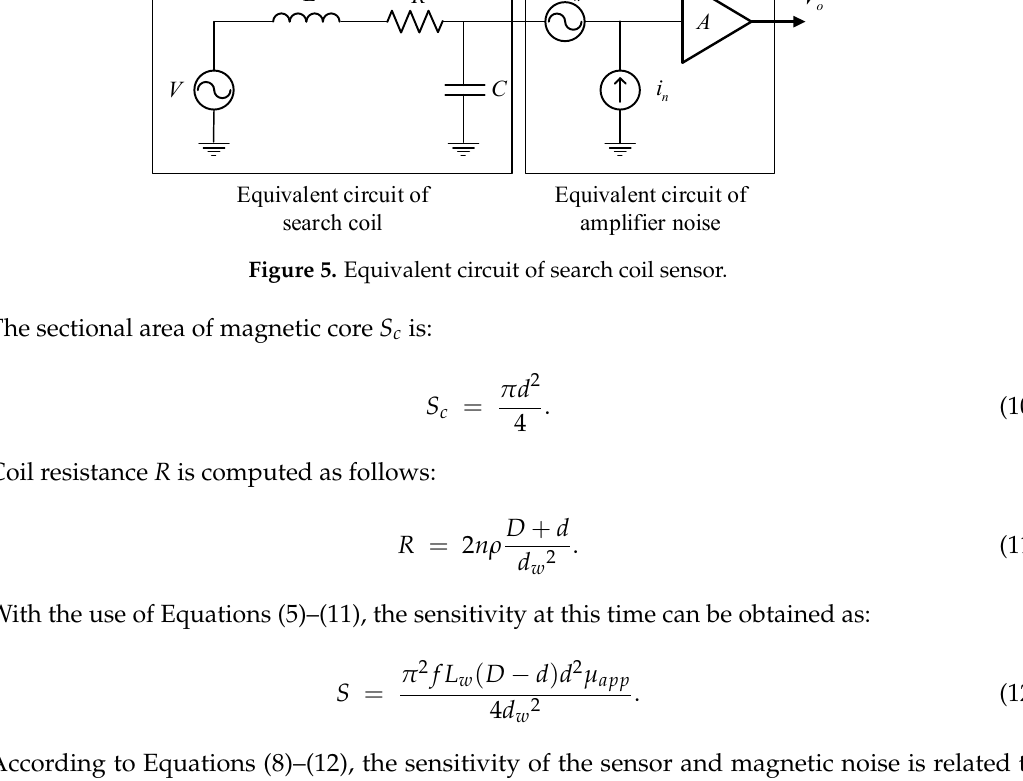
Figure 6. Relation curve between magnetic noise, sensitivity, number of coils, resistance, total noise spectral density, and wire diameter d w (Fixed parameters